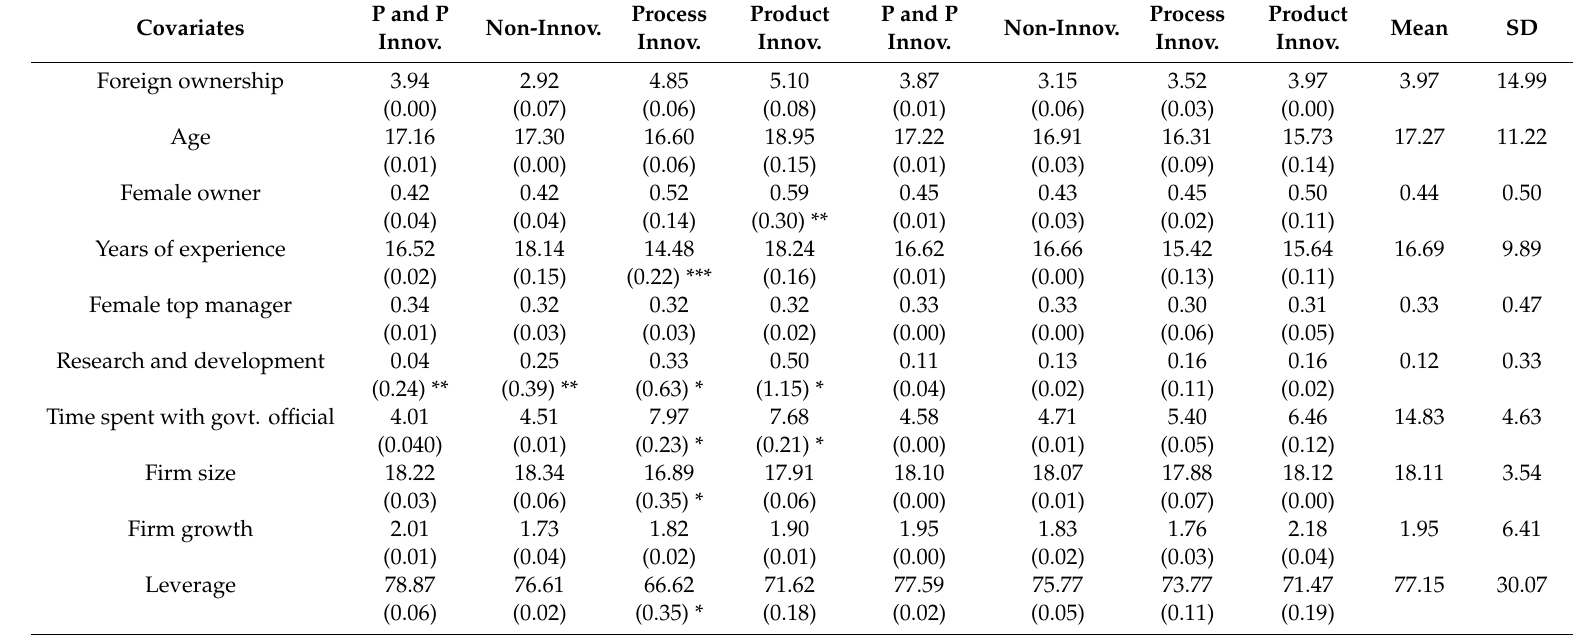
Table 3. Mean values for covariates in unweighted and weighted